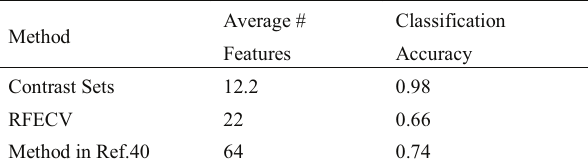
Table 7. Lengths of the discovered contrast sets of the Breast Cancer Wisconsin (Prognostic)